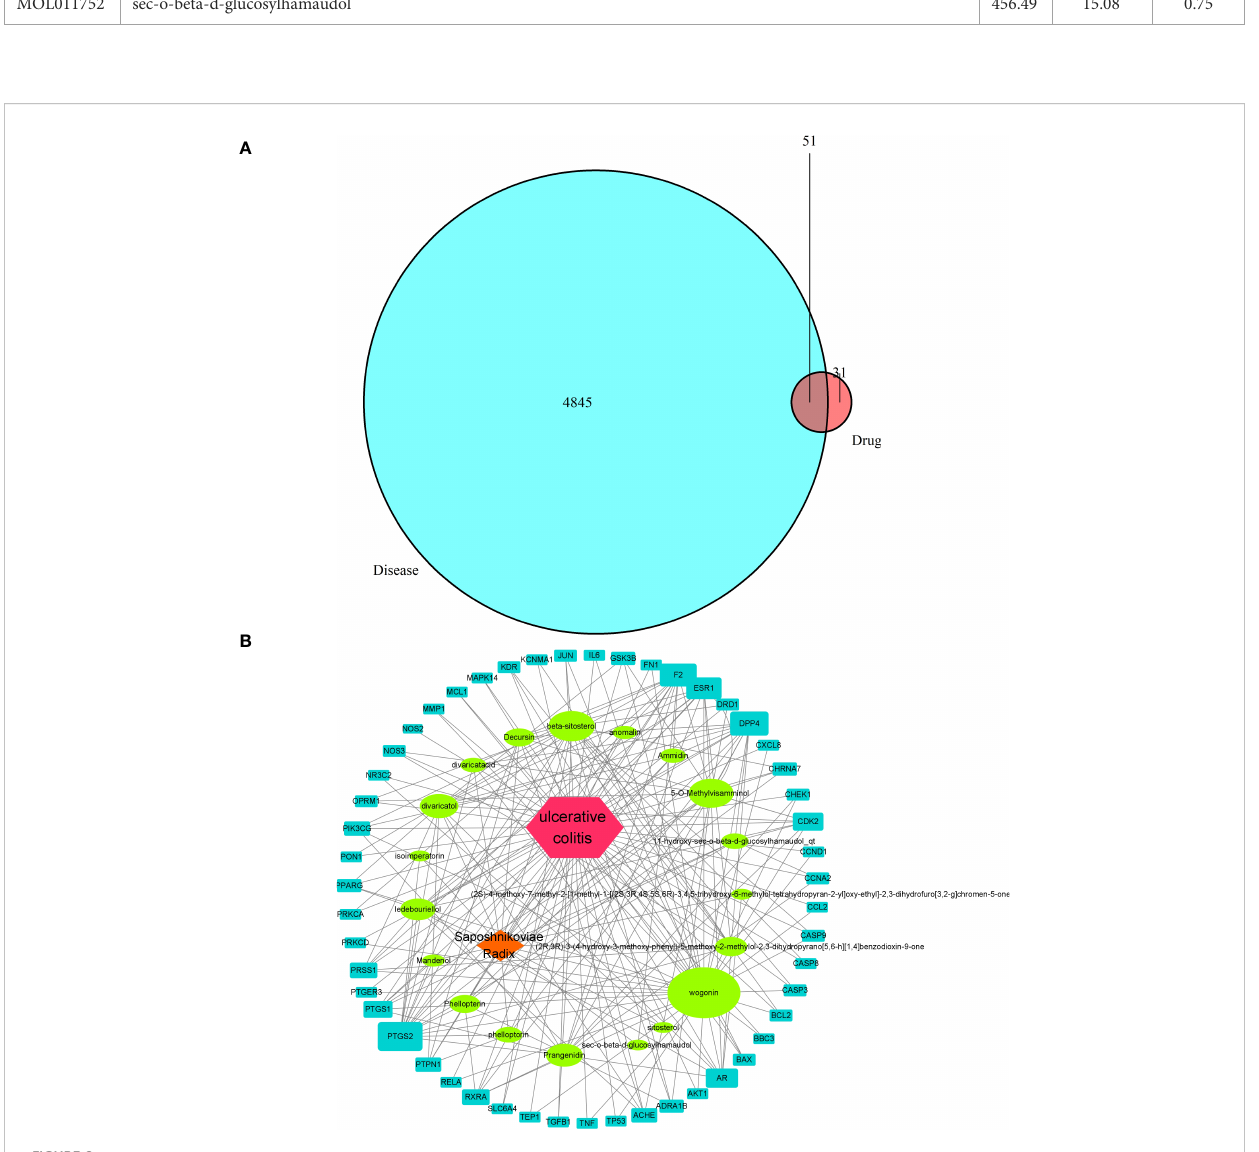
FIGURE 8 Drug-disease target intersection in Venn diagram (A) and visual analysis of S. divaricata in the treatment of ulcerative colitis (B)